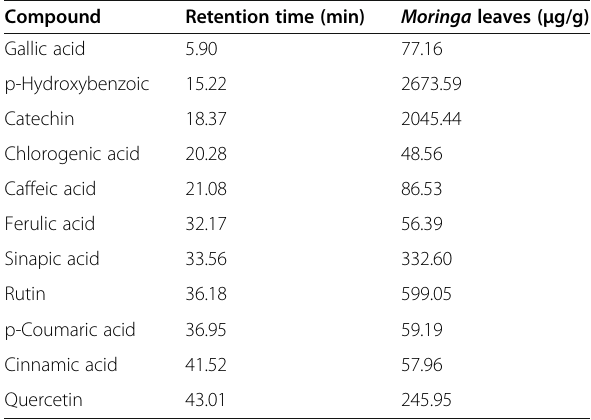
Table 2 High-performance liquid chromatography assay of phenolic and flavonoids compounds in Moringa oleifera extract